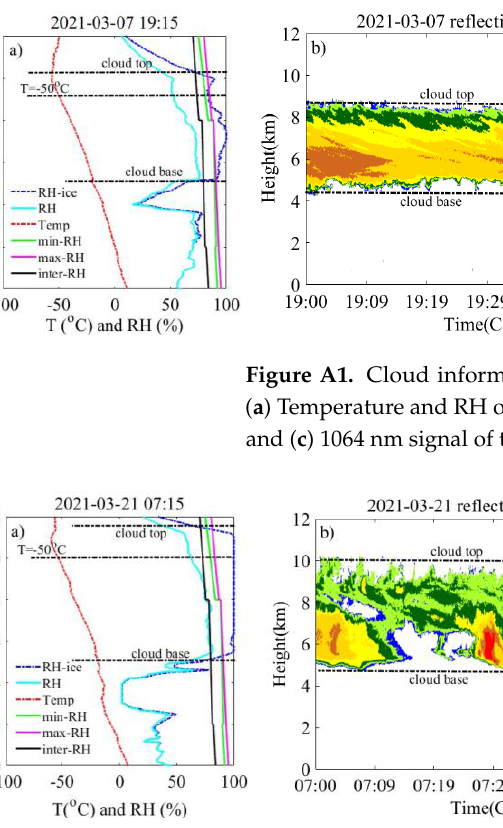
Figure A2. Cloud information observed by the radiosonde, MMCR, and lidar on 21 March 2021. ( a ) Temperature and RH obtained by the radiosonde, ( b ) reflectivity factor observed by the MMCR, and ( c ) 1064 nm signal of the lidar.